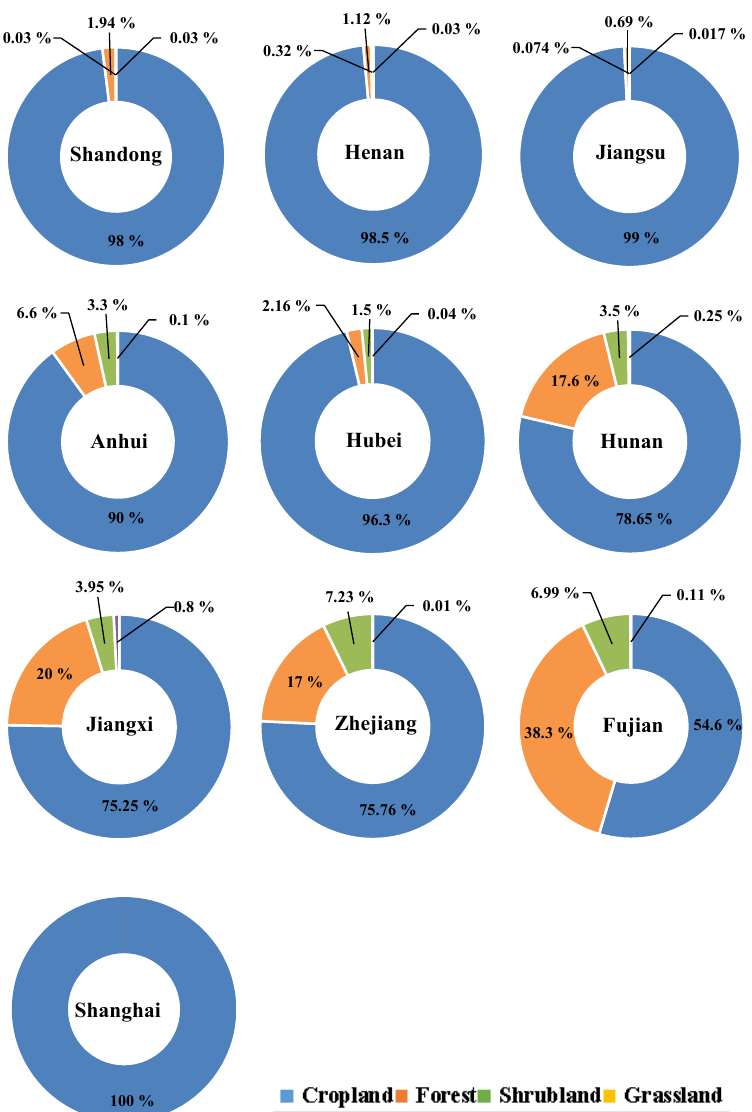
Figure 3. The averaged contributions of different biomass burning types to PM 2 . 5 emission in each